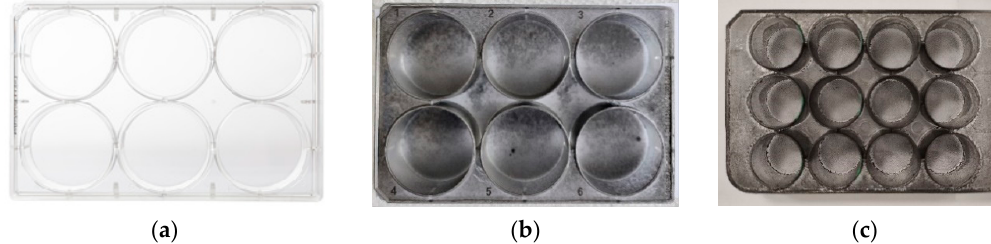
Figure 3. Culture plate ( a ) without coating; ( b ) covered with a base ink coating (without surfactant); and ( c ) covered with an ink coating containing 5% surfactant.